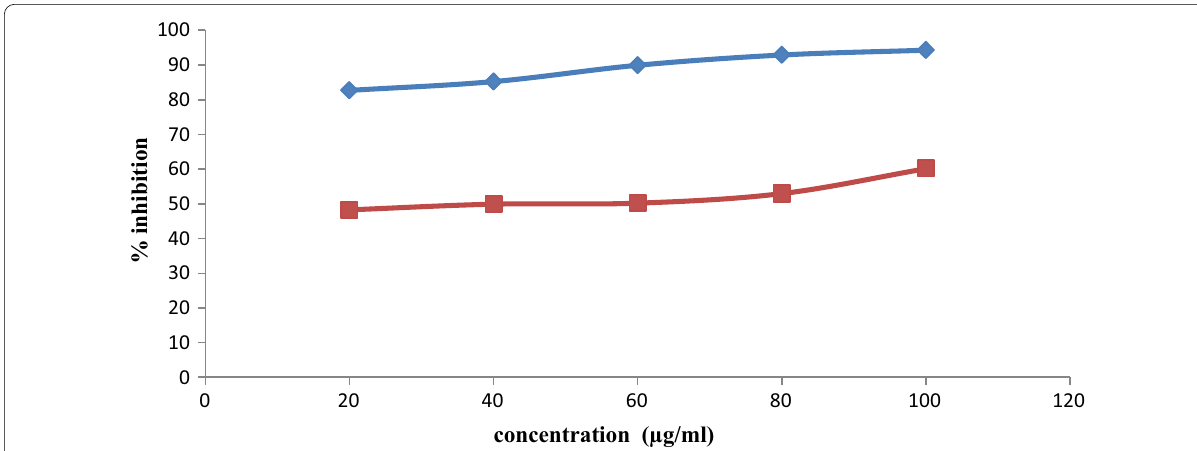
Fig. 1 DPPH scavenging activities of crude n-hexane extracts of Ipomoea batatas L . leaves. Blue—day 1, Red—day 7, Orange—day 14. Blue— ascorbic acid, Red— I.